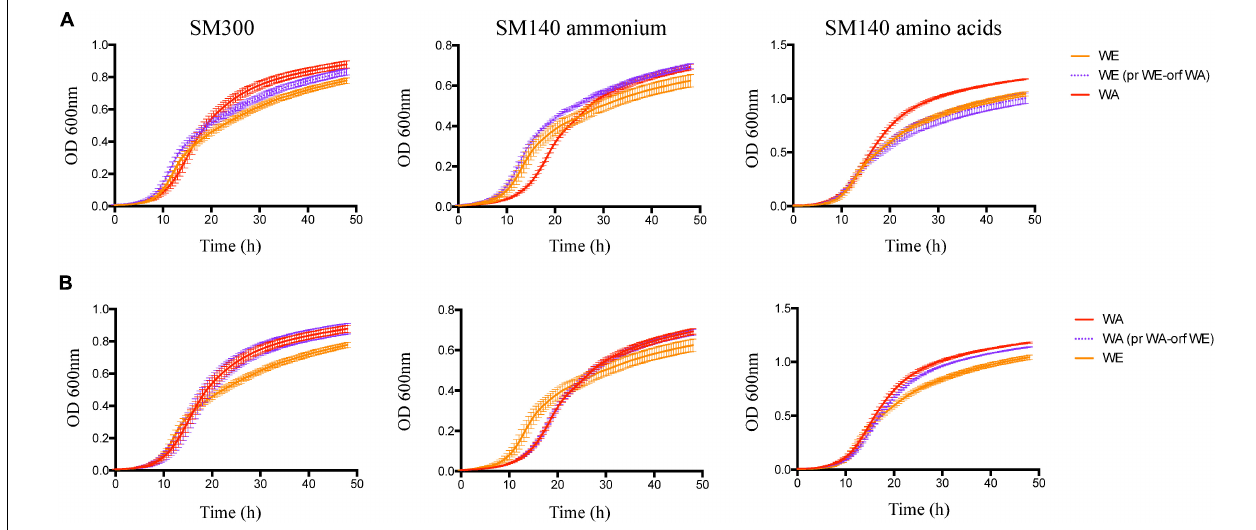
FIGURE 7 | Growth performance for the WE and WA strains with GTR1 allele swapping. (A) Growth curves for the strains with GTR1 ORF swapping in WE genetic background, and WA genetic background (B) . Plotted values correspond to the average of three biological replicates, with their standard error represented by bars (mean ± SE). WE, Wine/European; WA, West African; pr, Promoter; orf, Open Reading Frame